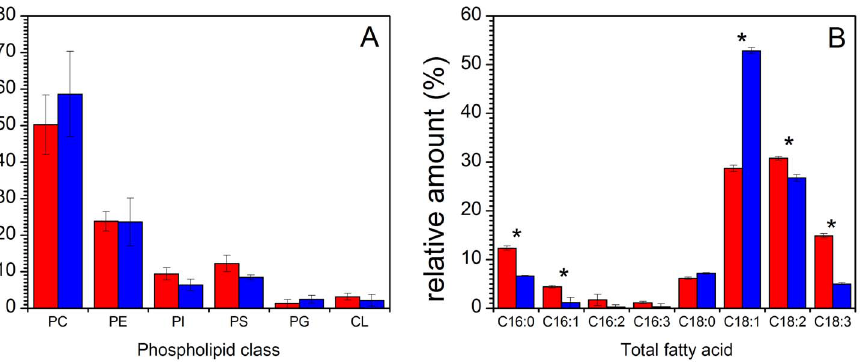
Figure 2. Phospholipid and fatty acid composition of PichiaPastoris cells. (A) Phospholipid composition and (B) total fatty acid distribution of Pichia pastoris cells grown in a hydrogenated medium (red) and in a deuterated environment (blue) at 30 u C. PC, phosphatidylcholine; PE, phosphatidylethanolamine; PI, phosphatidylinositol; PS, phosphatidylserine; PG, phosphatidylglycerol; CL, cardiolipin or diphosphatidyglycerol. Data represent mean values 6 s.d (n=3). In histograms, * P , 0.05 from Student’s t -test, assuming equal